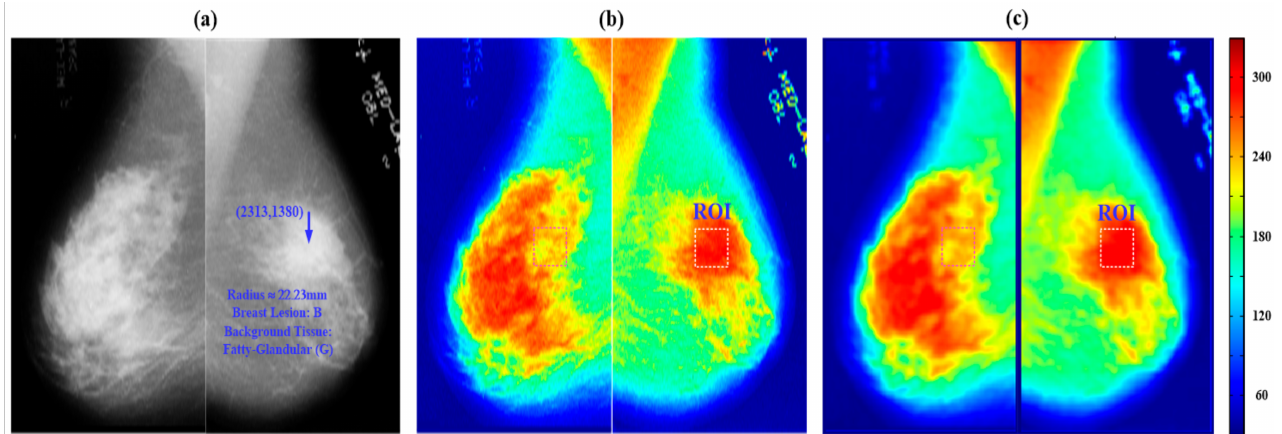
Figure 3. Two-dimensional spatial convolutional processes by using fractional-order-based convolu- tional and integral image operations. ( a ) Original mammographic image; ( b ) image enhancement with fractional-order-based spatial convolutional operation; ( c ) image enhancement with spatial integral imager-based spatial convolutional